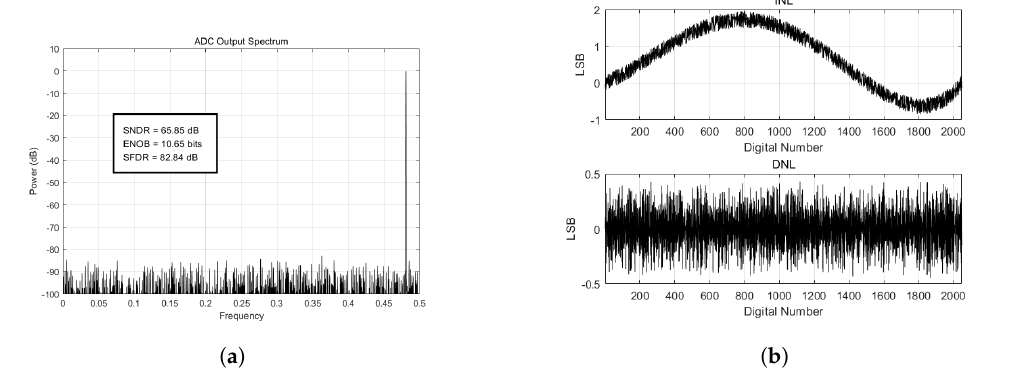
Figure 23. ( a ) spectrum plot; ( b ) INL and DNL of the measured output in the LG